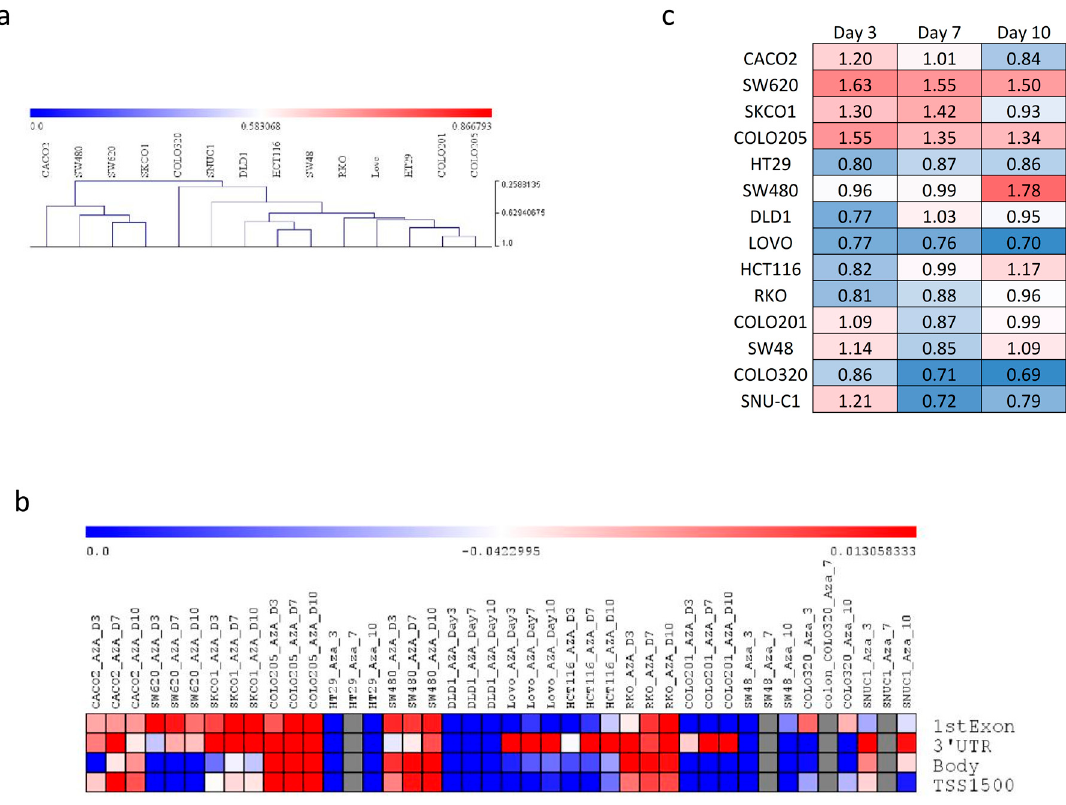
Figure 8. In vitro effect of the hypomethylating agent 5-azacitidine (AZA) on the expression of KCNMA1 in 14 human colon cancer cell lines. ( a ) Hierarchical clustering was performed on the KCNMA1-associated methylation levels, as obtained from the GSE57342 dataset; ( b ) heatmap showing the modulation of KCNMA1 gene methylation upon AZA treatment of 14 human colon cancer cell lines, as obtained from the GSE57342 dataset. The mean beta value is presented; ( c ) heatmap showing the modulation of KCNMA1 upon AZA treatment of 14 human colon cancer cell lines, as obtained from the GSE57341 dataset. The fold change variation respective to the untreated cells is presented.